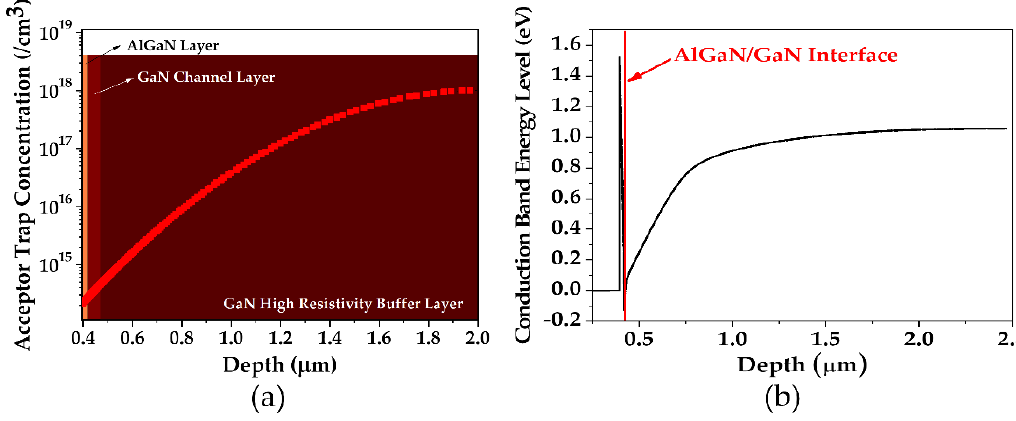
Figure 2. ( a ) Substrate acceptor trap concentration and ( b ) conduction band energy level of the simulated device as a function of depth. The traps are located 0.8 eV below the conduction band edge.